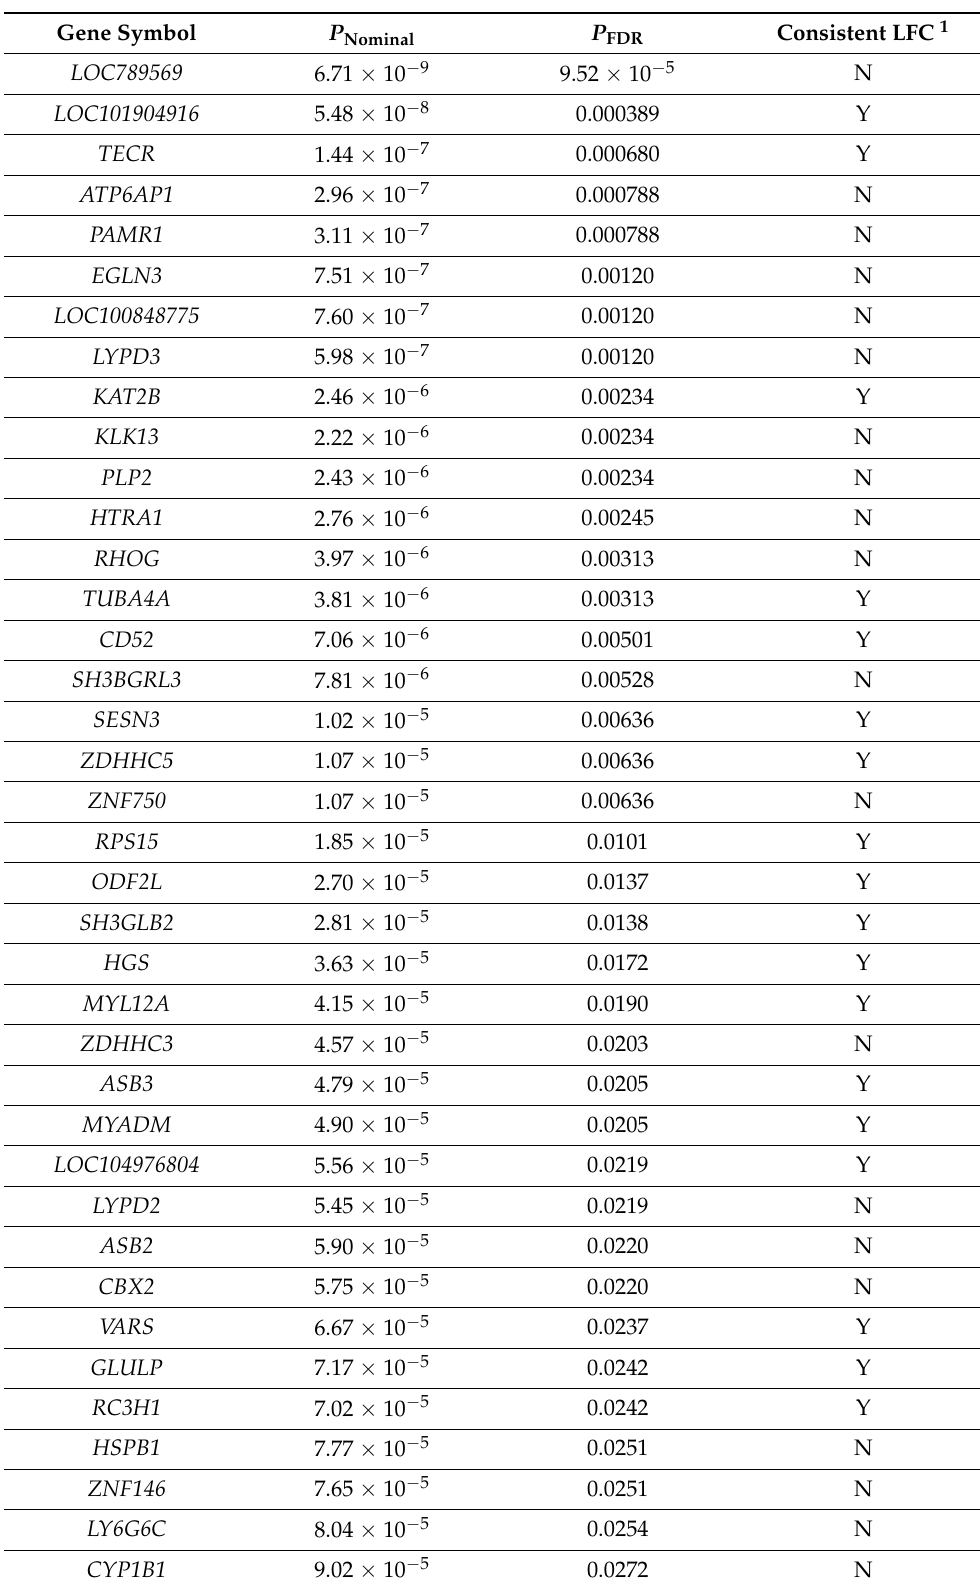
Table 1. Genes identified as differentially expressed between low versus high RFI beef cattle in a meta-analysis of two unrelated populations of